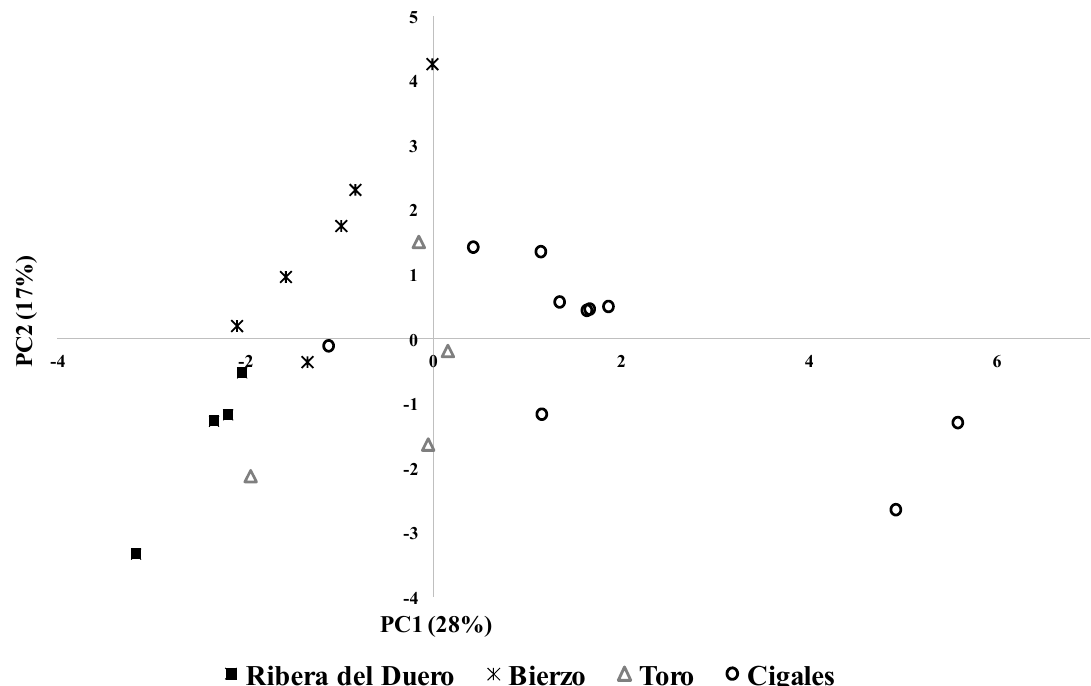
Figure 2. Distribution of rosé wines from different PDOs in the plot defined by the first two principal components (PC). Table 5. PCA loading values of the variables selected in rosé wines.